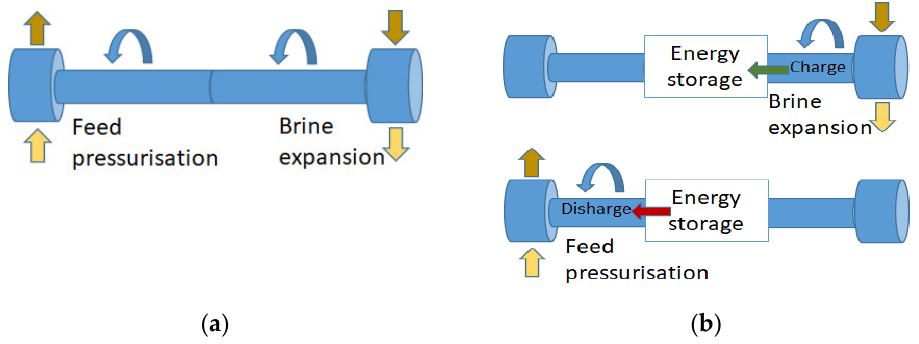
Figure 4. Conceptual diagrams of: ( a ) a conventional turbocharger and ( b ) a possible energy recovery device with discontinuous operation for SWRO desalination with a CCD configuration.